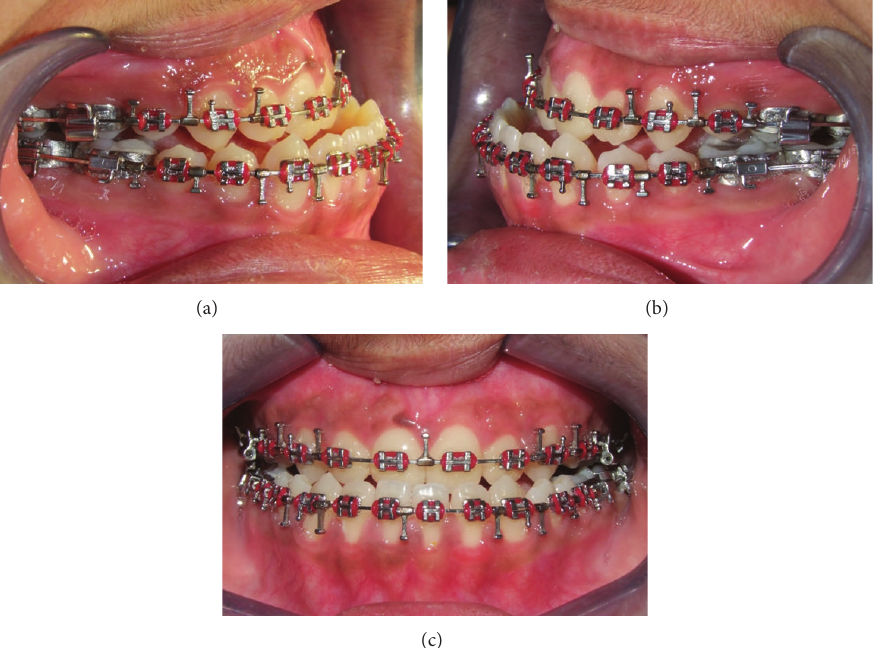
Figure 9: Presurgical occlusion, (a) right, (b) left, and (c) front.